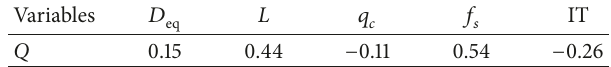
Table 2: Correlation coefficient between input and output variables.